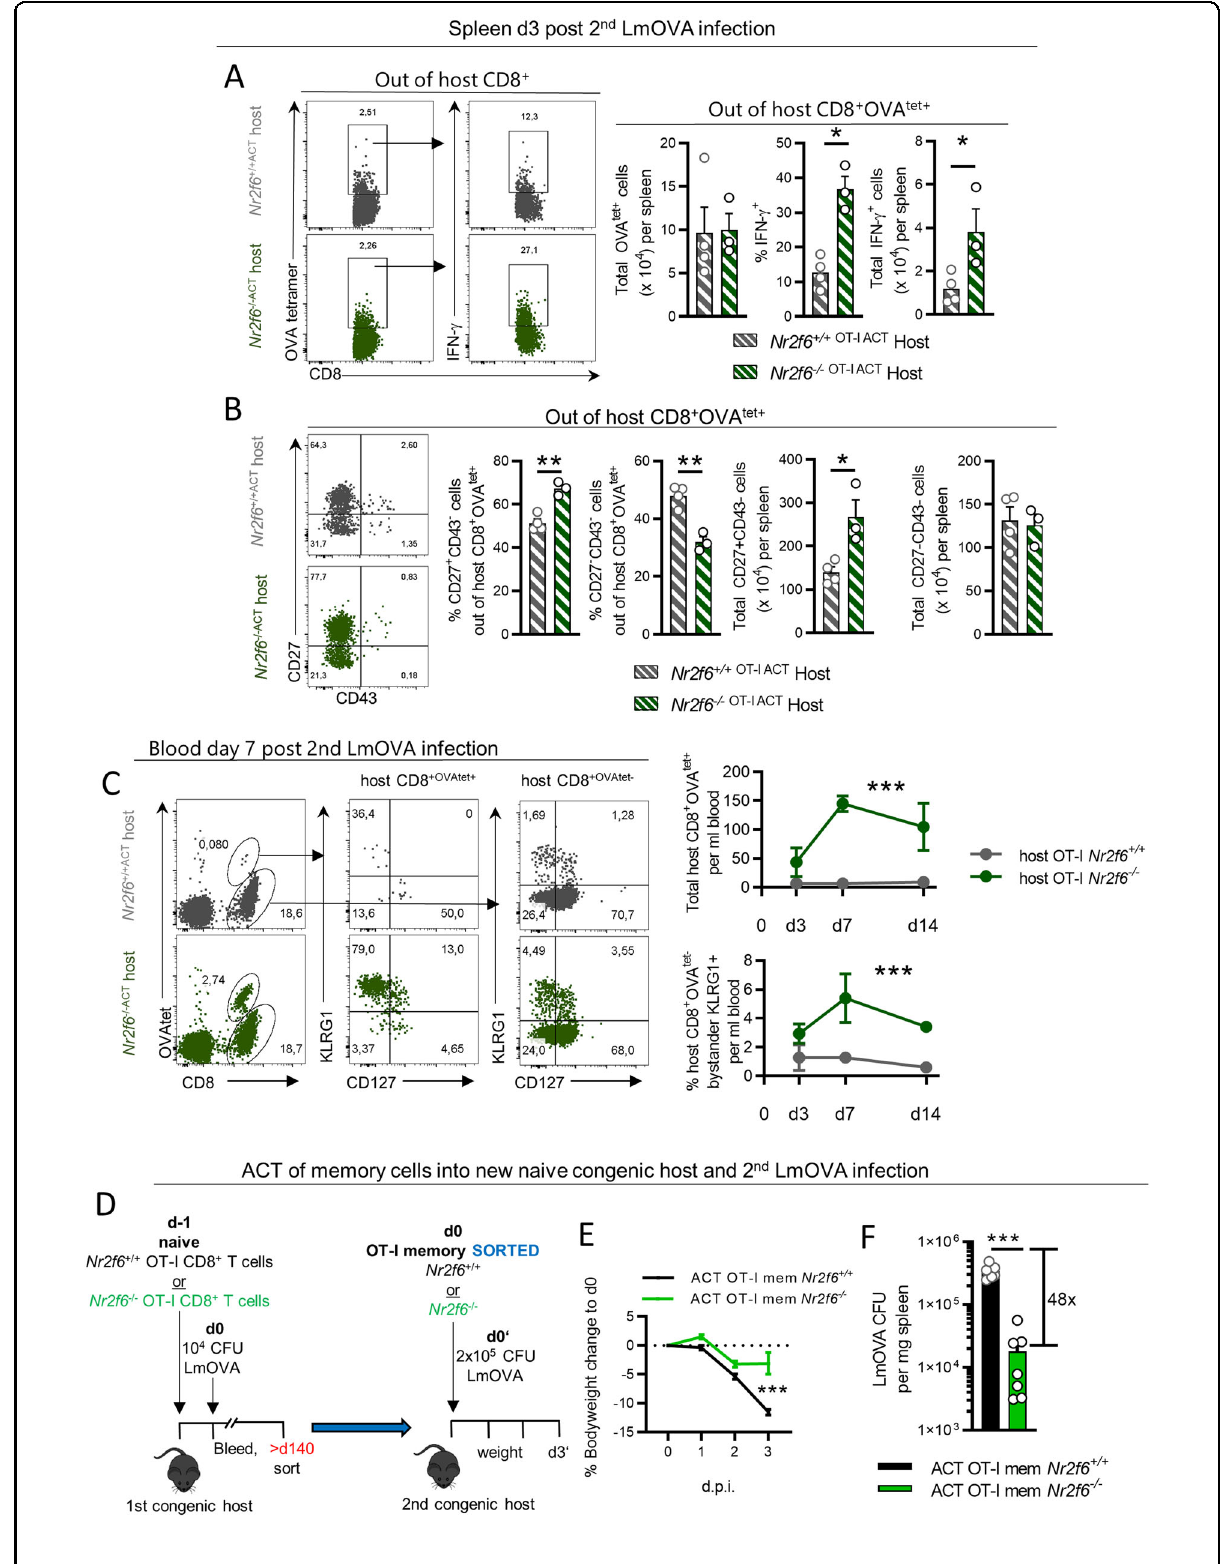
Fig. 4 (See legend on next